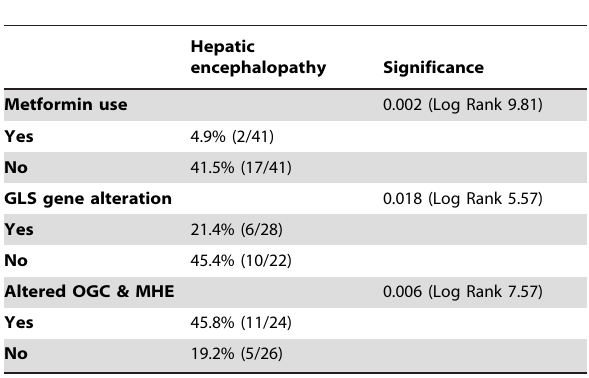
Table 2. Univariate analysis between hepatic encephalopathy and